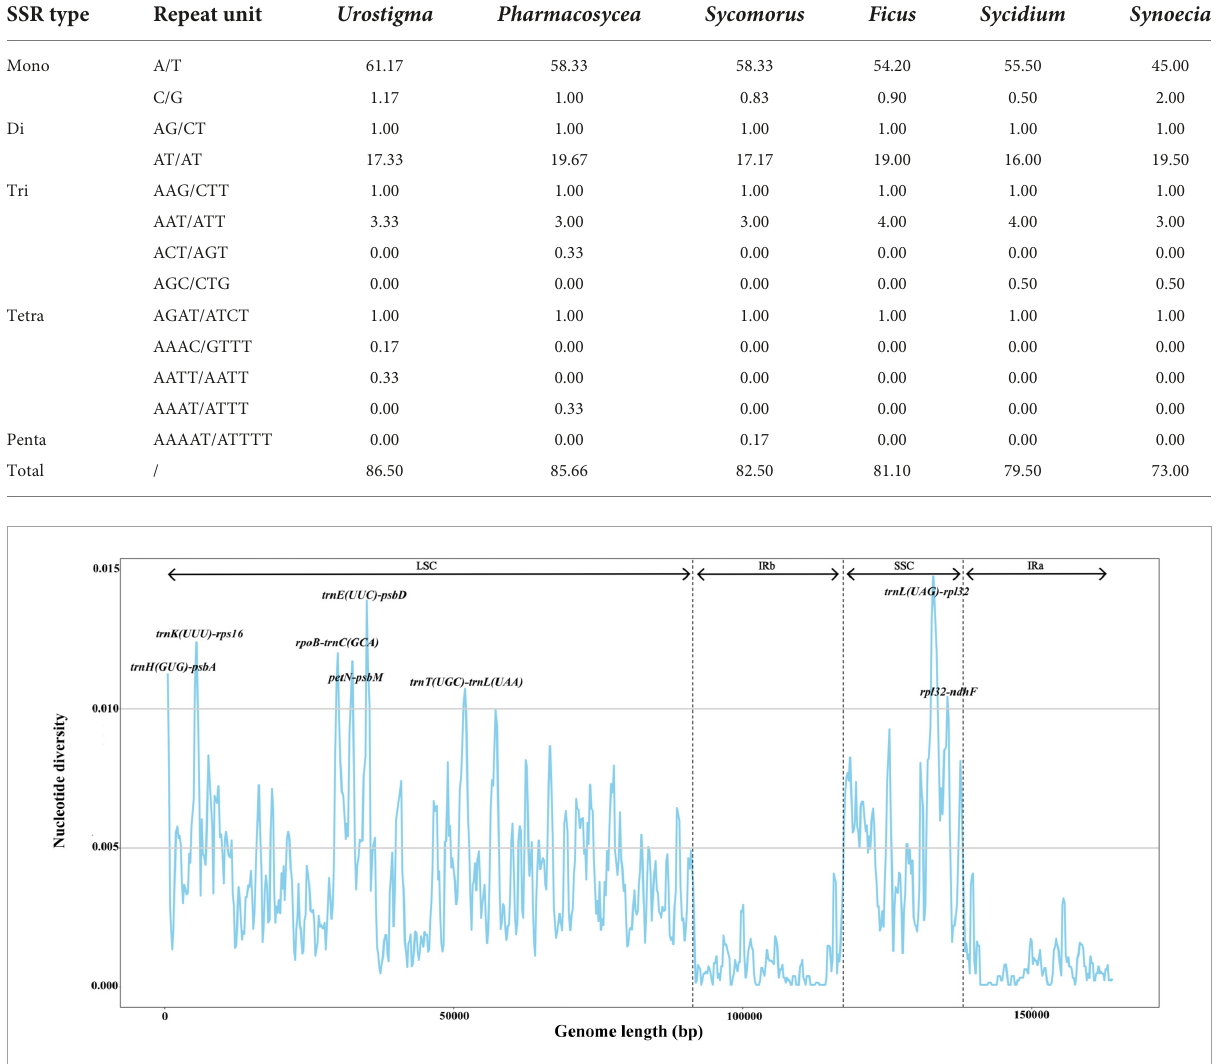
TABLE 2 Simple sequence repeats (SSRs) types and mean number of chloroplast genomes of six Ficus subgenera.